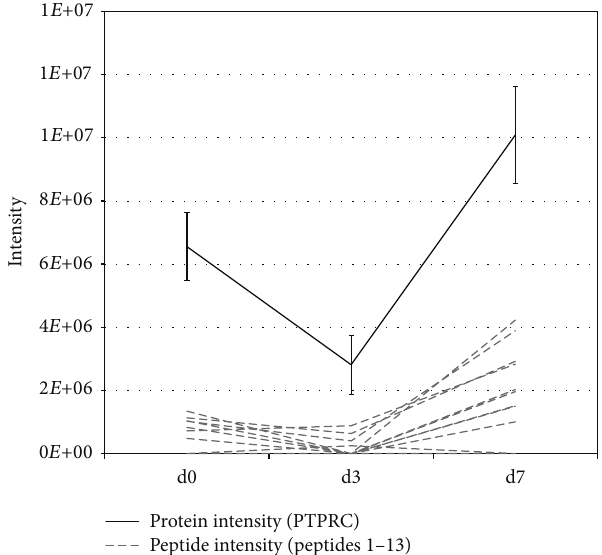
Figure 4: Expression of PTPRC. The labelfree intensity of PTPRC (alsoknownasCD45)isquantifiedbasedon13uniquepeptideswith similar expression profiles. A significant down regulation with a fold change of − 2.33 was observed between day 0 and day 3. From day 3 to day 7 a significant up regulation with a fold change of +3.6 was